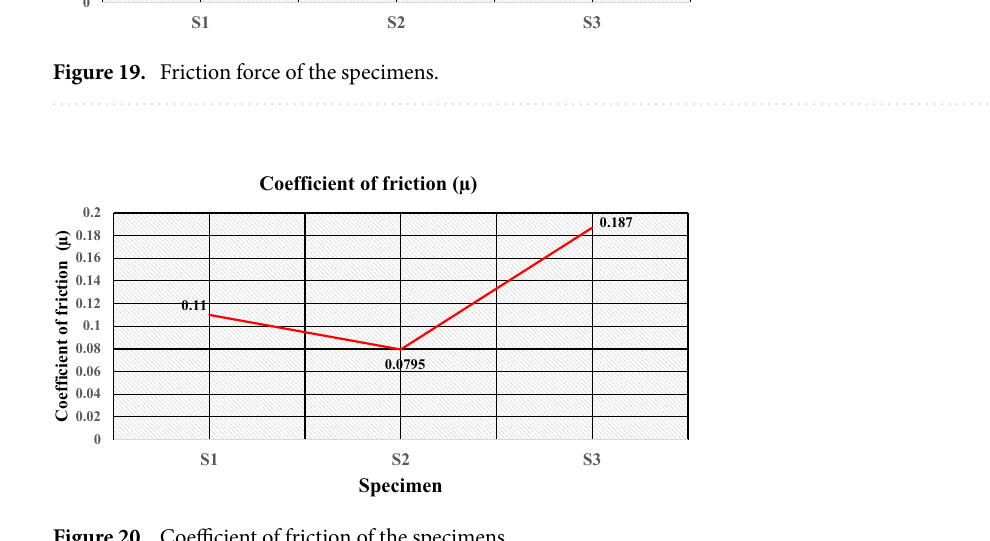
Figure 20. Coefficient of friction of the specimens.